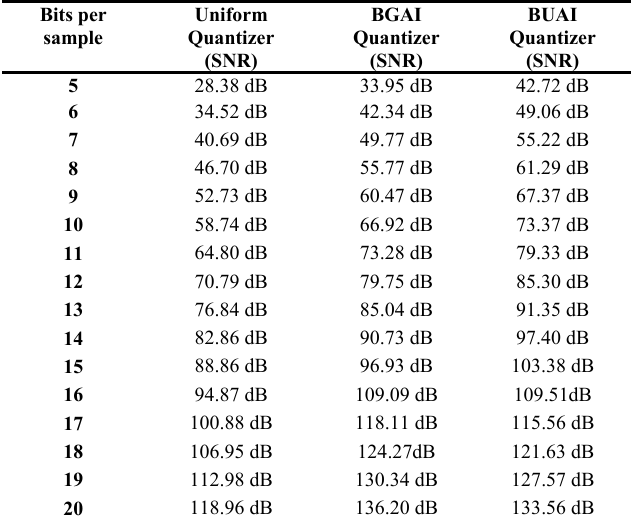
Table 2: The comparison among calculated SNR of the proposed methods and a uniform